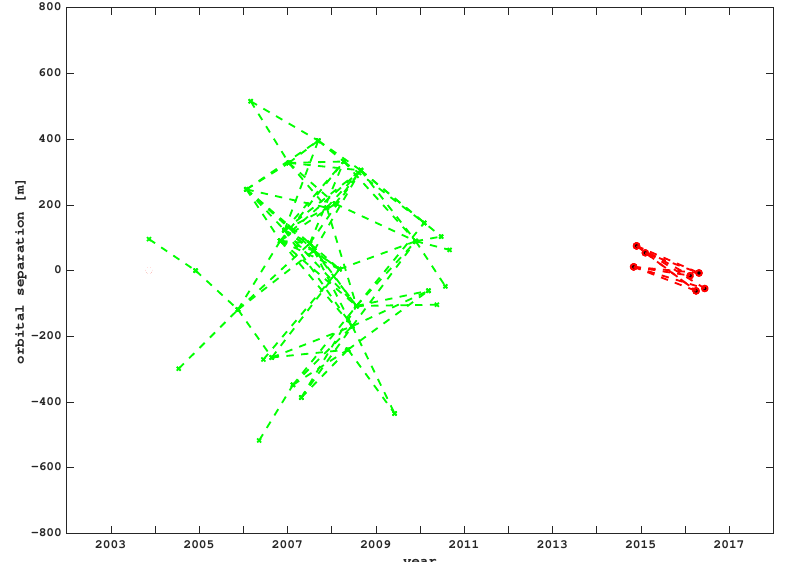
Figure 2. Data set of interferometric pairs included in the analysis. Pairs shown in green are the minimum spanning tree subset of 81 pairs from Envisat between 2004 and 2010 picked according to orbital separation, plotted as the perpendicular component of the “baseline” vector separating the satellite’s trajectories at the two times (“epochs”) of image acquisition. Pairs shown in red are the 10 pairs from the Sentinel-1A satellite between 2014 and